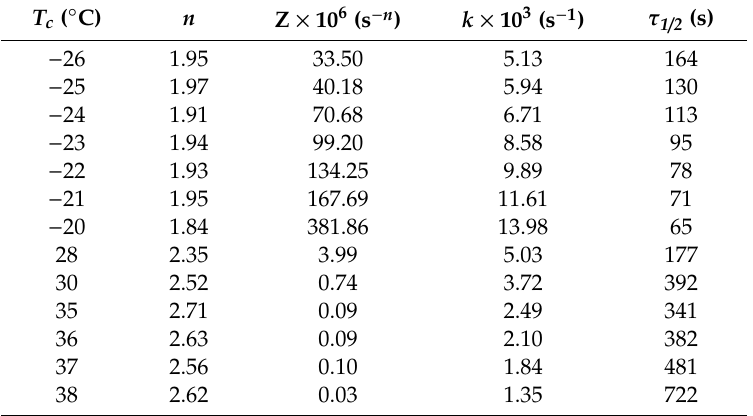
Table 1. Isothermal crystallization kinetic parameters deduced from calorimetric (DSC) experiments for poly(4-hydroxybutyrate